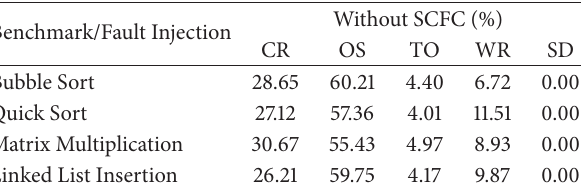
Table 2: Fault injection results on Memory Manager with